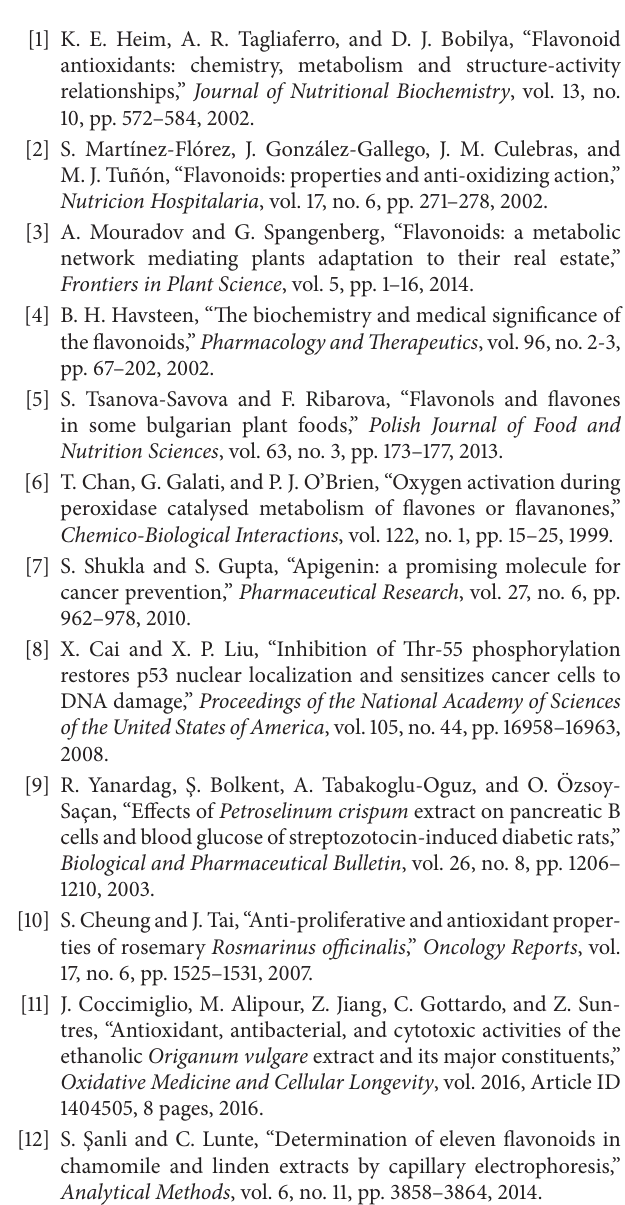
Table 2: Concentration of apigenin in different herbs. Herb